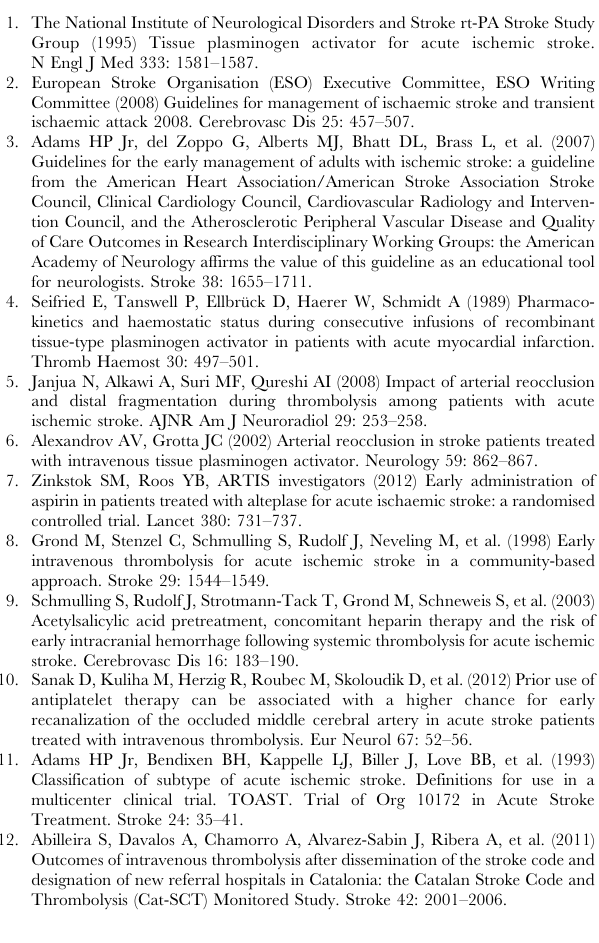
Table S1 General characteristics of study population according to the antithrombotic drug used. Table S2 General characteristics of study population according to the pre-stroke antithrombotic